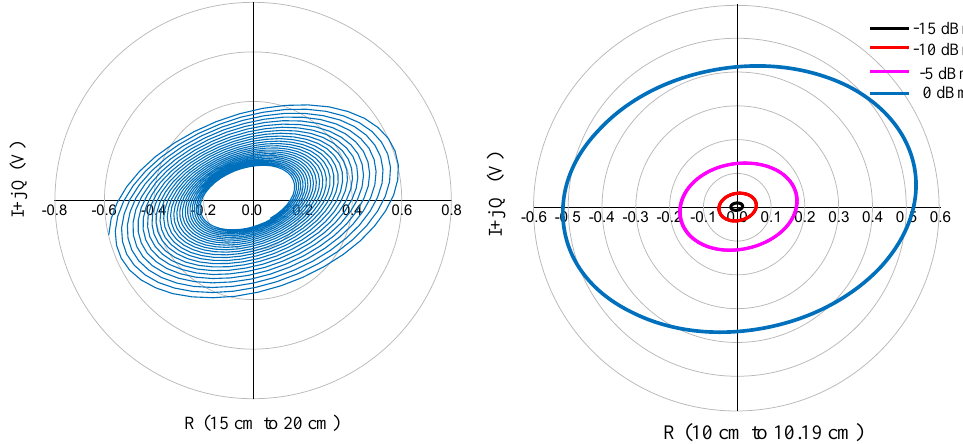
Figure 15. Simulation results for the displacement of the target near the antenna for various input